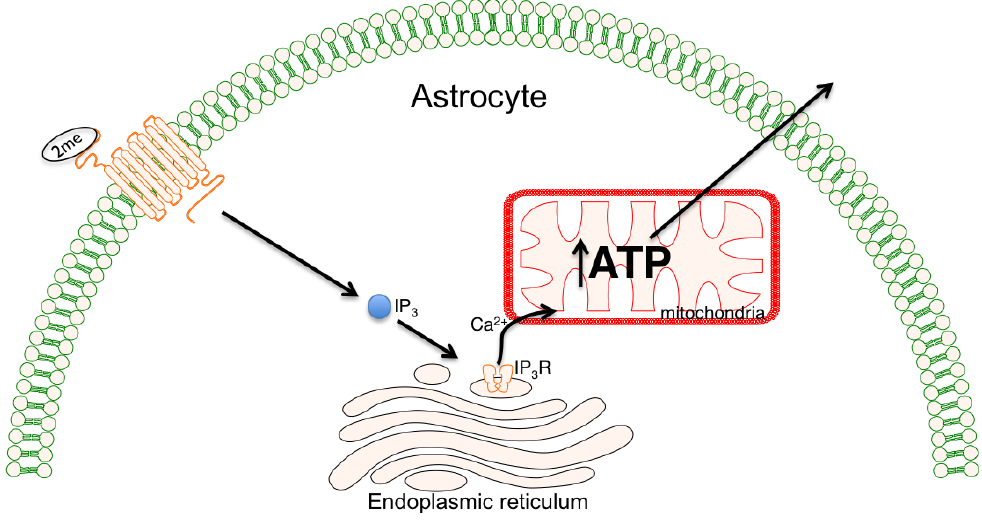
R) activates the Inositol triphosphate (IP 1 3